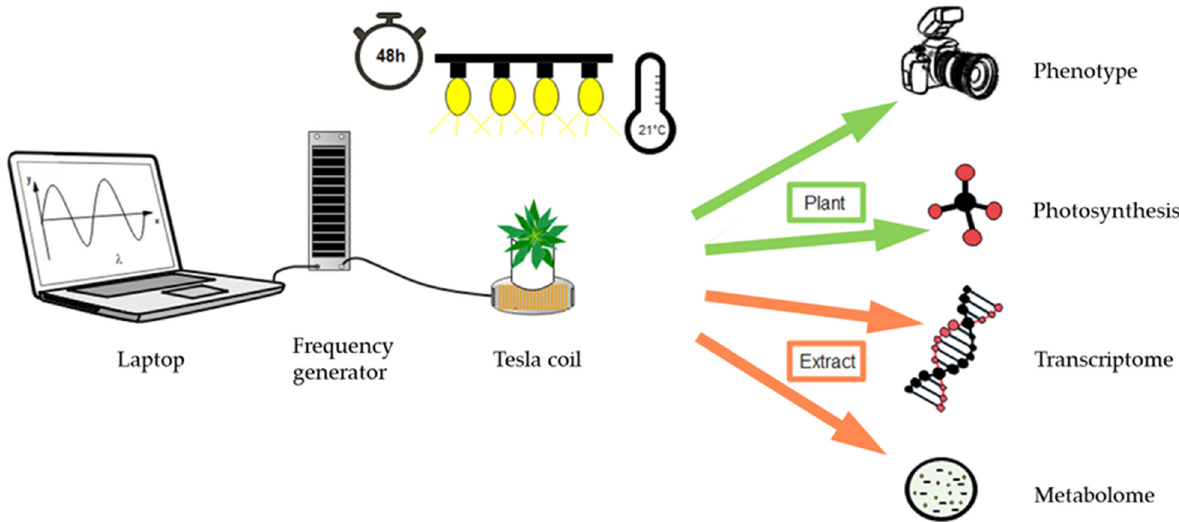
Figure 1. Schematic representation of the experimental setup used for electromagnetic field irradiation and analysis of plant material. The plants were grown and treated at 21 °C and 10/14 h day/night conditions. The settings for the electromagnetic irradiation were transferred to the Tesla coil via the frequency generator. The treated plants were placed on the emitter and irradiated for 48 h. The untreated plants were placed outside of the irradiated area. The intact plants were phenotypically and photosynthetically analyzed, while the transcriptome and metabolome analysis were carried out with plant extract.